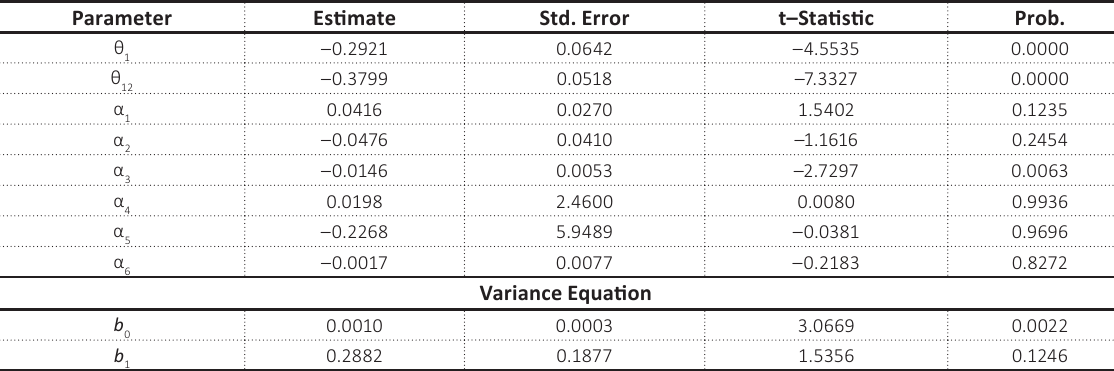
Table A2. Estimation results for (5-6) model